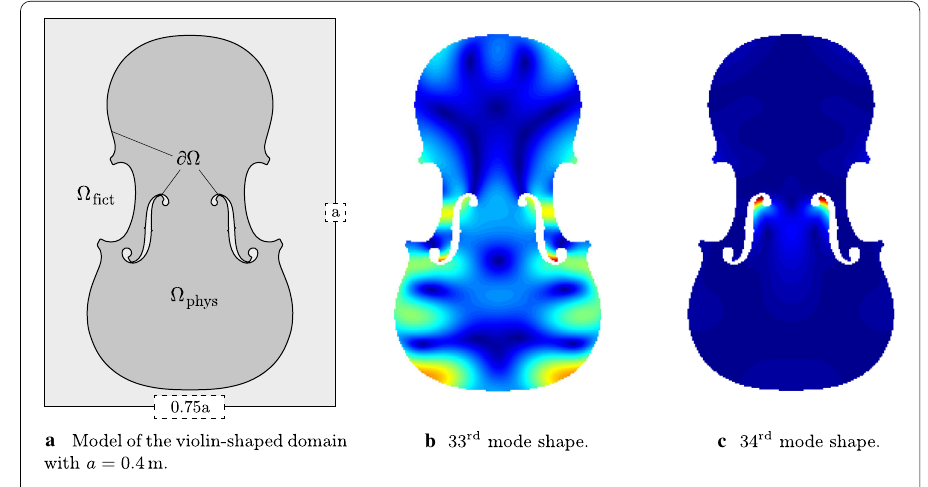
Fig. 27 Violin-shaped domain with two of its mode shapes. The visualization is based on the magnitude of the normalized ( u max = 1) displacement vector